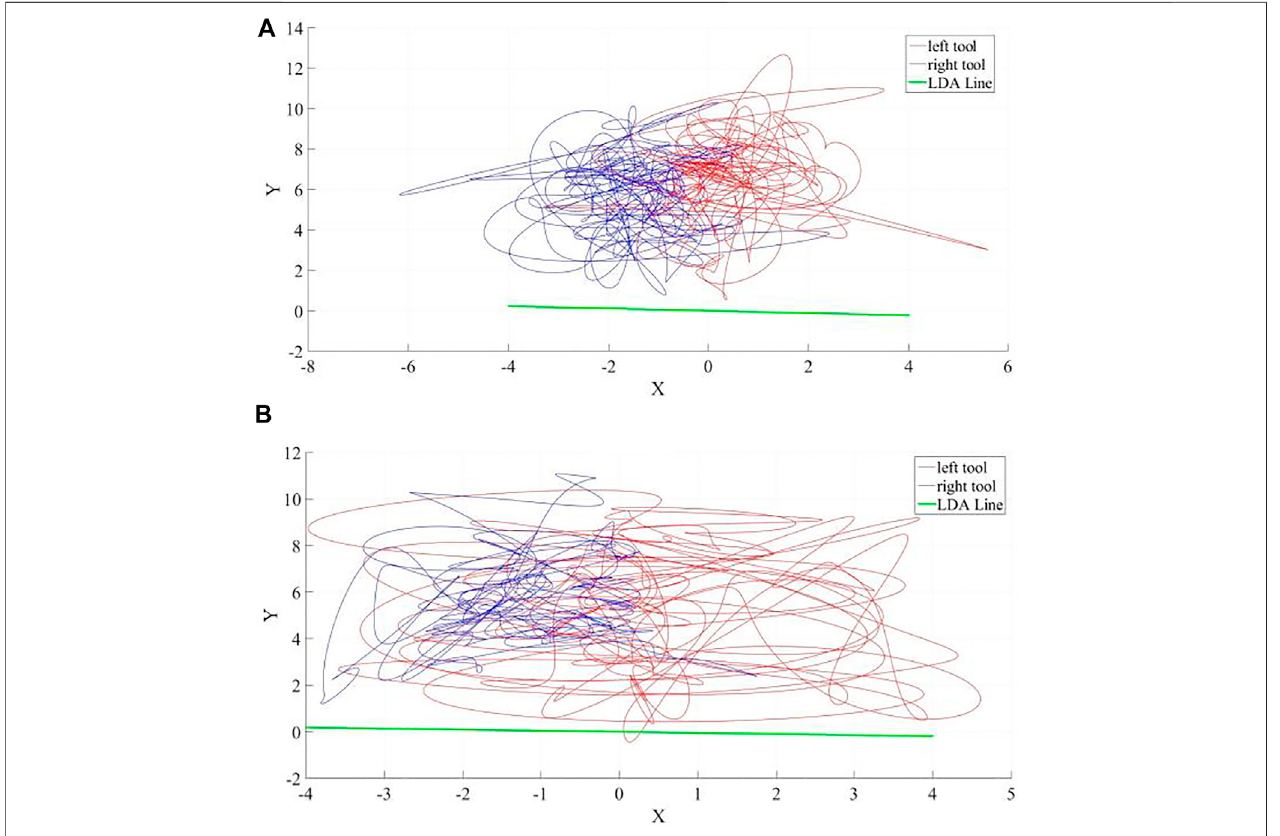
FIGURE 12 | Sample laparoscopy instrument tip-point trajectories (units: cm) as successfully discriminated to belong (A) to a professional and (B) to a novice by our novel assessment criterion based on Linear Discriminant Analysis (LDA) presented in (Gautier et al., 2019). The right-hand instrument (the driver) trajectory is in red and the left-hand instrument (the receiver) trajectory is in blue. The LDA line in green shows the best direction to distinguish the right-hand and left-hand instruments according to their spatial distribution and as expected it is almost the same in each case in this speci fi c suturing exercise; re fl ecting that the orientation of the suturing line is the same and perpendicular to the axis that separates right and left hand tools.